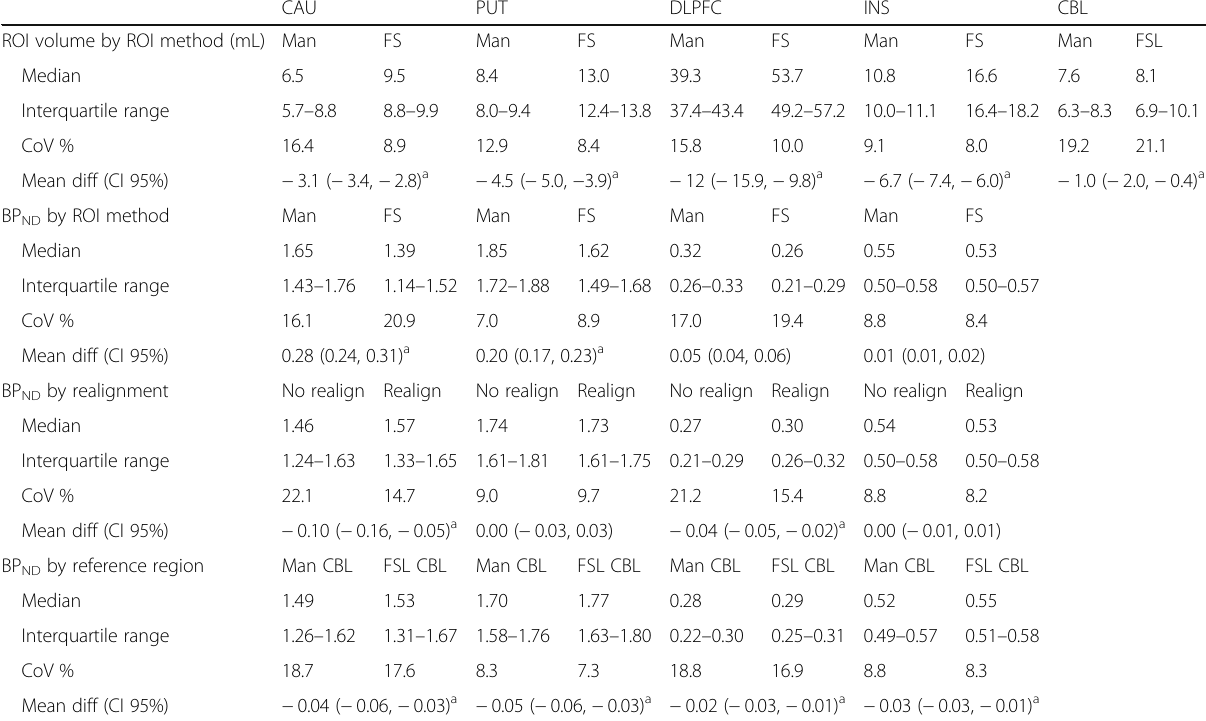
Table 2 ROI volumes and binding potential (BP ND ) values for [ 11 C]SCH23390 binding obtained by two repeated PET measurements analyzed by three different comparisons of methods: (1) ROI definition (manual (Man)/FreeSurfer (FS)), (2) movement correction (no realignment/realignment), and (3) definition of the cerebellum as reference region (manual/modified FSL)